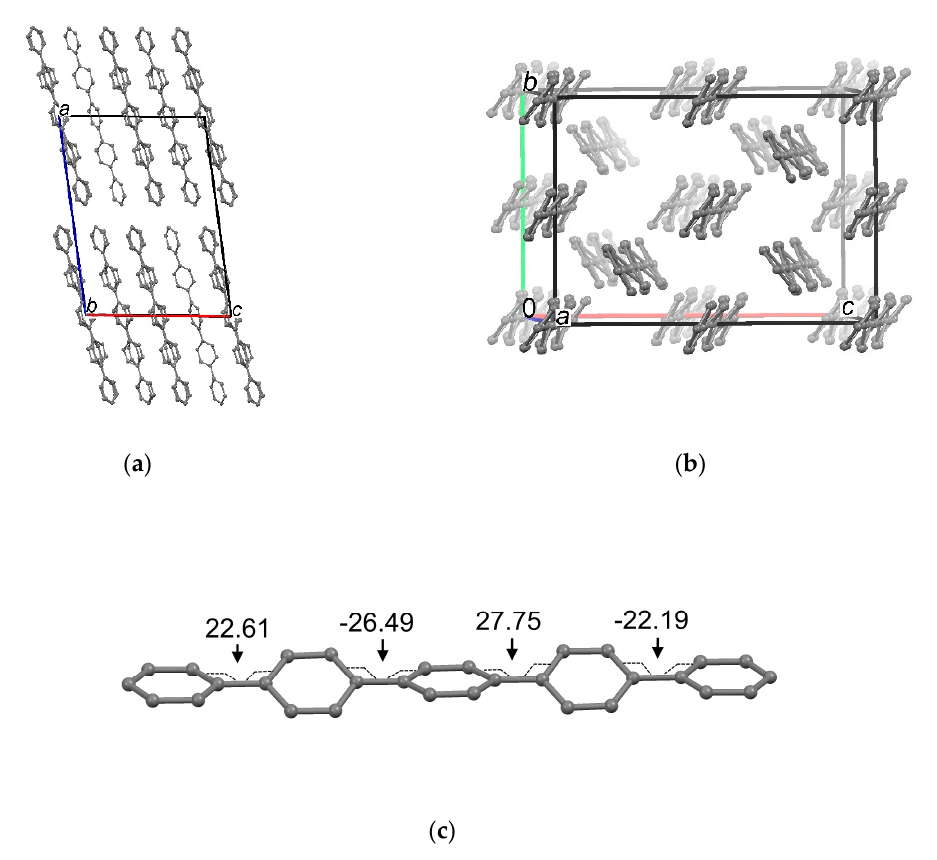
Figure 5. Crystal structure of p-quinquephenyl at 85K: ( a ), ( b ) the unit cell projections onto the planes (010) ( a ) and (100) ( b ) (dark molecules in the upper layer, light molecules in the lower layer); ( c ) a conformation of the molecule in the crystal with the values of torsion angles between the phenyl rings.